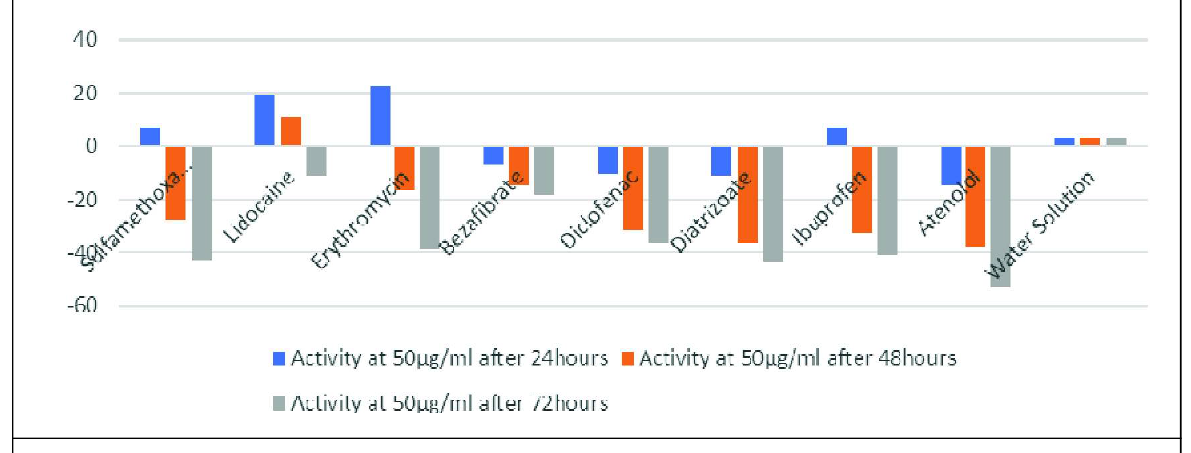
Figure 2: Chronic growth stimulation and inhibition of Bacillus subtilis at 50 µ g/ml